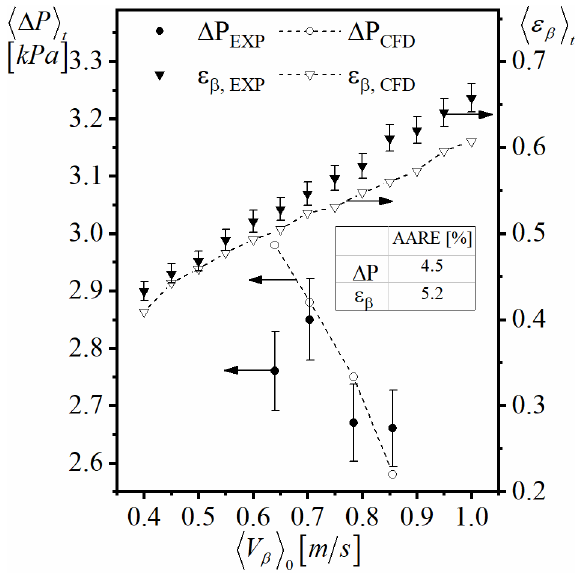
Figure 8. Validation of the overall gas holdup and pressure drops.